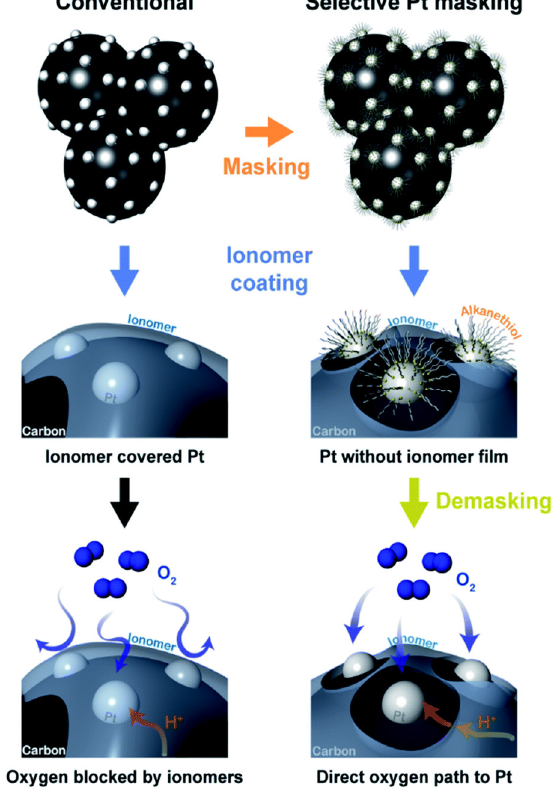
Figure 6. Schematics of the distribution of ionomer on carbon and Pt nanoparticles in the conven- tional case ( left ), the selective distribution of ionomer on only carbon surface through masking Pt nanoparticles ( right ), as well as the oxygen/proton transport in both cases. (Reprinted from Ref. [103] with permission from the Royal Society of Chemistry).